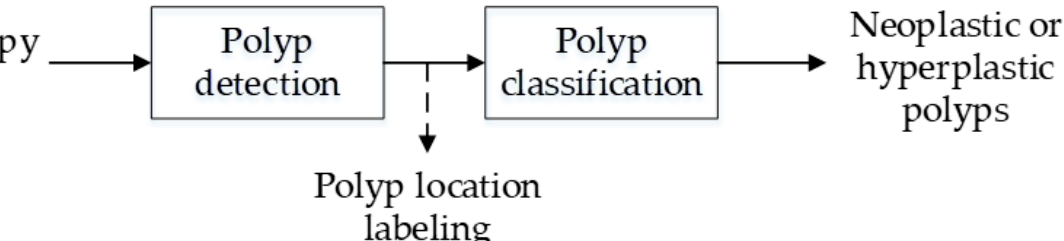
Figure 6. System architecture.